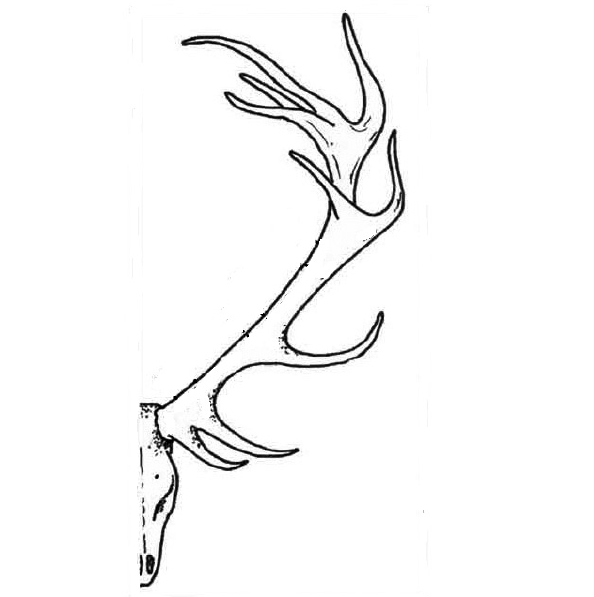
Figure 10. A schematic picture of a deer antler. A good cross-sectional image of a deer antler is available in Ref.